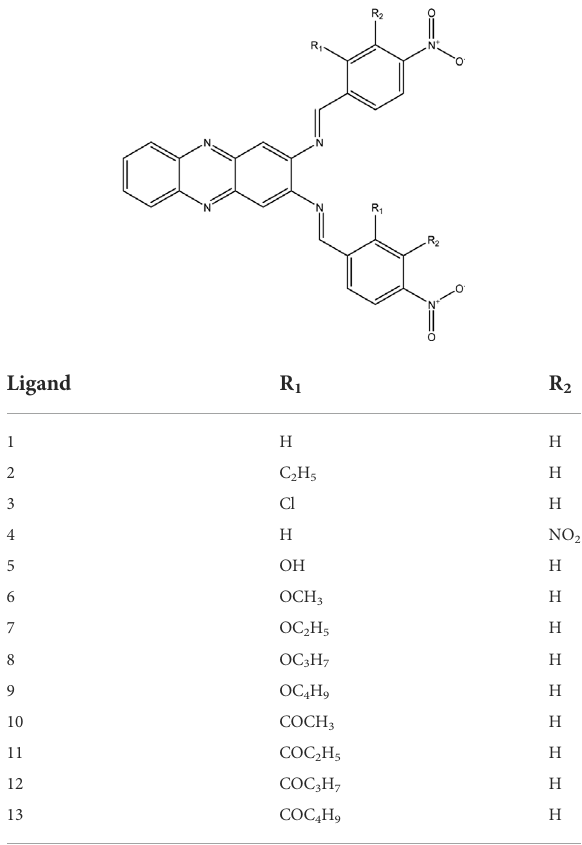
TABLE 1 The thirteen nitro-benzylidene phenazine derivatives used in the hits screening.